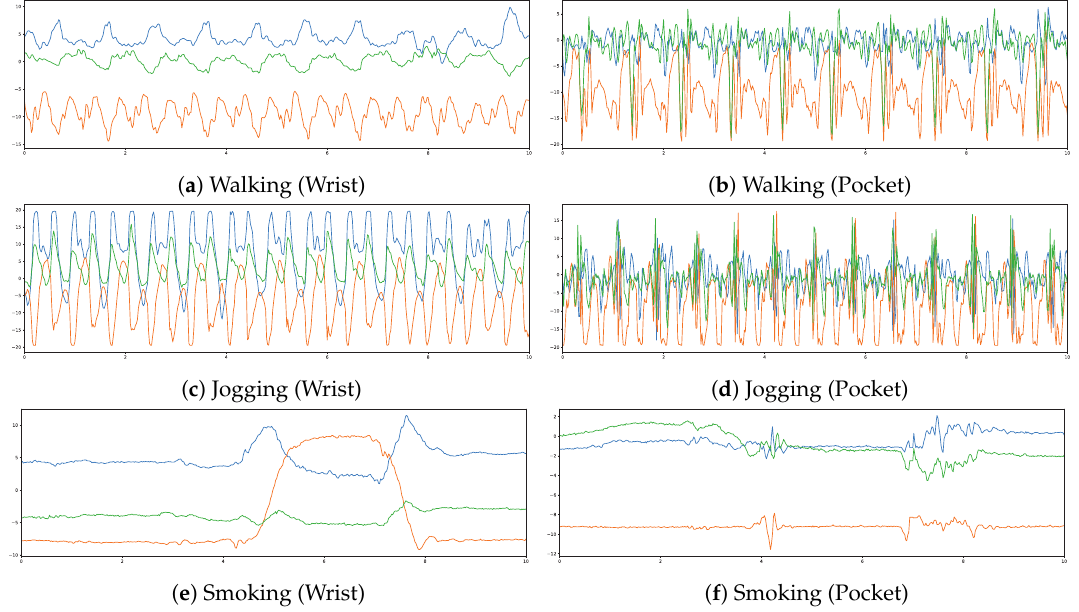
Figure 6. Motion captured by the accelerometer (in ms − 2 ) located in the wrist ( left ) and the pocket ( right ), for ten seconds of walking, jogging and smoking. Blue is the x component, orange is the y component, and green is the z component of the